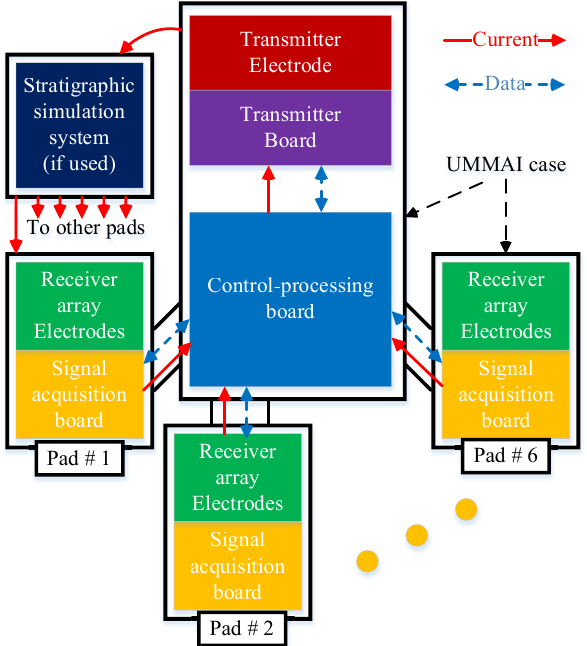
Figure 3. The simplified measurement equivalent circuit in actual measurement environment.